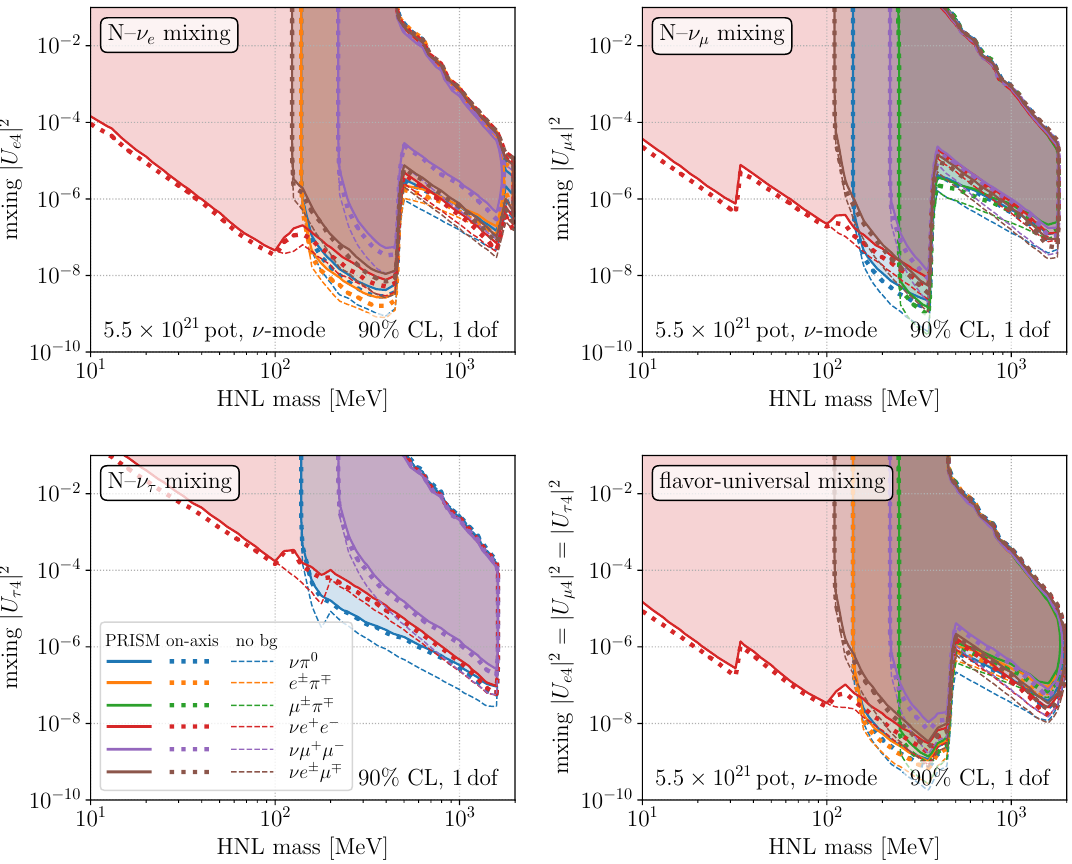
Figure 10 . Sensitivity to HNLs in the DUNE near detectors ND-LAr and ND-GAr as function of HNL mass. Solid lines correspond to the DUNE-PRISM running strategy with data taking both on-axis and at six different off-axis locations ( 6 m , 12 m , 18 m , 24 m , 30 m , 36 m ), with equal exposure for each location. The total number of protons on target assumed here is 5 . 5 × 10 21 , corresponding to 5 years of running in neutrino mode. Dotted lines show the sensitivity for on-axis data taking only, and thin dashed lines have been computed from a DUNE-PRISM analysis that neglects backgrounds. The four panels correspond to different HNL coupling structures, namely mixing with ν only (top left panel), with ν only (top right panel), with ν only (bottom left e µ τ panel), and flavor-universal mixing | U 2 = | U 2 = | U 2 ≡ | U | 2 (bottom right e 4 | µ 4 | τ 4 |